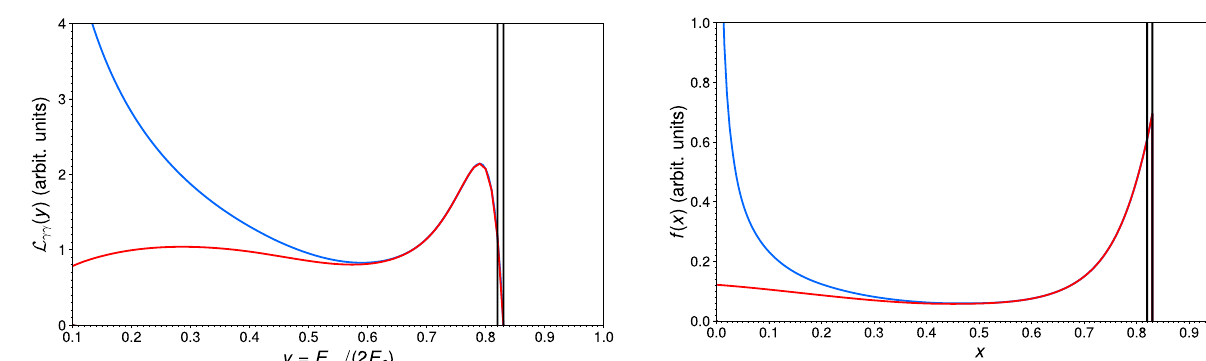
Fig. 2 Luminosity spectra L γγ ( y ) used in this work: idealized spec- trum ∝ δ( y − y max ) (black); analytic spectrum L nc γγ ( y ) for κ max = 4 . 8 and 2 λ e P γ = − 1 (red); spectrum L c γγ ( y ) including multiple Compton scattering effects and beamstrahlung (blue). All of then are normalized to the same value of L γγ ( y > 0 . 8 y max ) (see text for details)